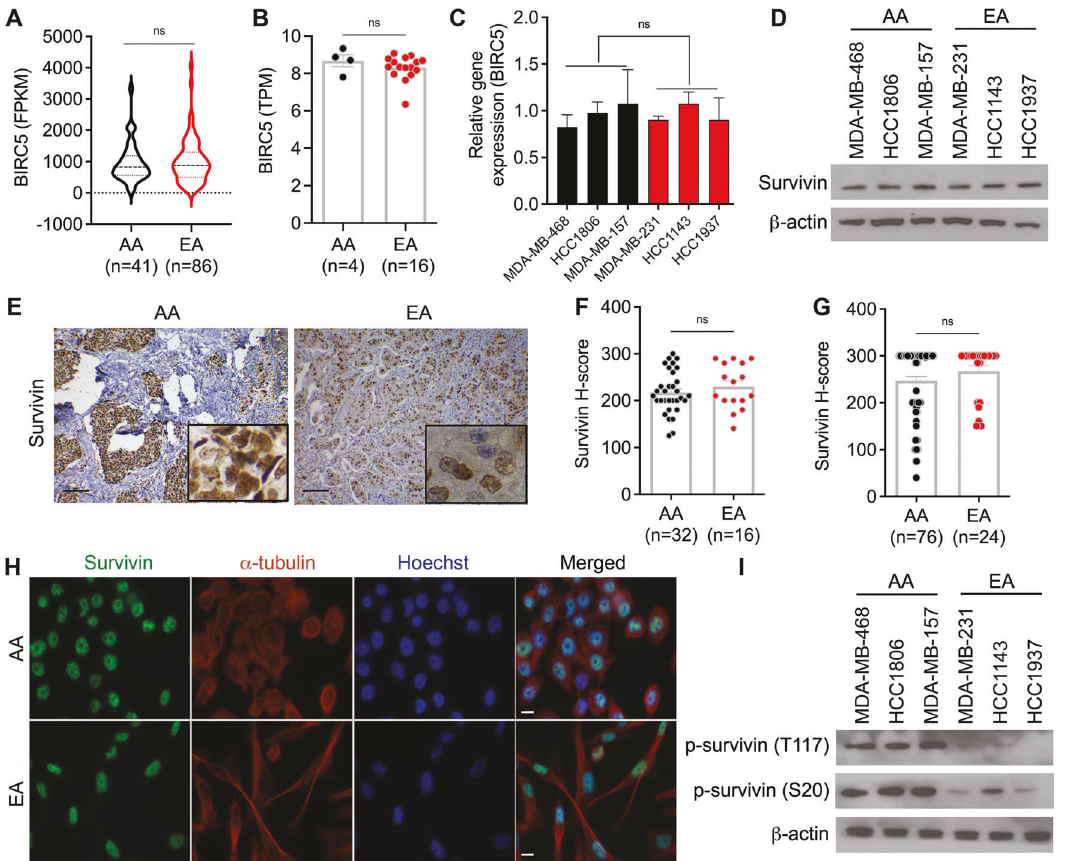
Fig. 2 Survivin expression, localization, and phosphorylation in AAs and EAs with TNBC. A BIRC5 expression level in AA and EA patients with TNBC (TCGA dataset). B Relative BIRC5 expression in AA and EATNBC cell lines from Neve et al. (2006) ( B ) and our in-house TNBC cell lines ( C ) ( n = 3 each). D Immunoblot showing survivin levels in AA ( n = 3) and EA ( n = 3) TNBC cell lines. E – G Representative IHC images ( E ) and bar graphs ( F , G ) showing survivin H scores in AA and EA patients with TNBC in the Dekalb ( F ) and Emory ( G ) cohorts. H IF images showing the localization of survivin (green) in AA and EA TNBC cell lines. Nuclei were stained with Hoechst (blue) and tubulin (red). I Immunoblot showing p-survivin (S20, T117) levels in AA and EA TNBC cell lines ( n = 3 each). FPKM fragments per kilobase of transcript per million mapped reads, TPM transcripts per million mapped reads. Bars indicate mean ± SEM. Unpaired two-tailed Student ’ s t -test with Welch ’ s correction was used to determine statistical signi fi cance (* P < 0.05, *** P < 0.0005, ns = non-signi fi cant). Scale bars in E and H are 100 µm and 10 µm,